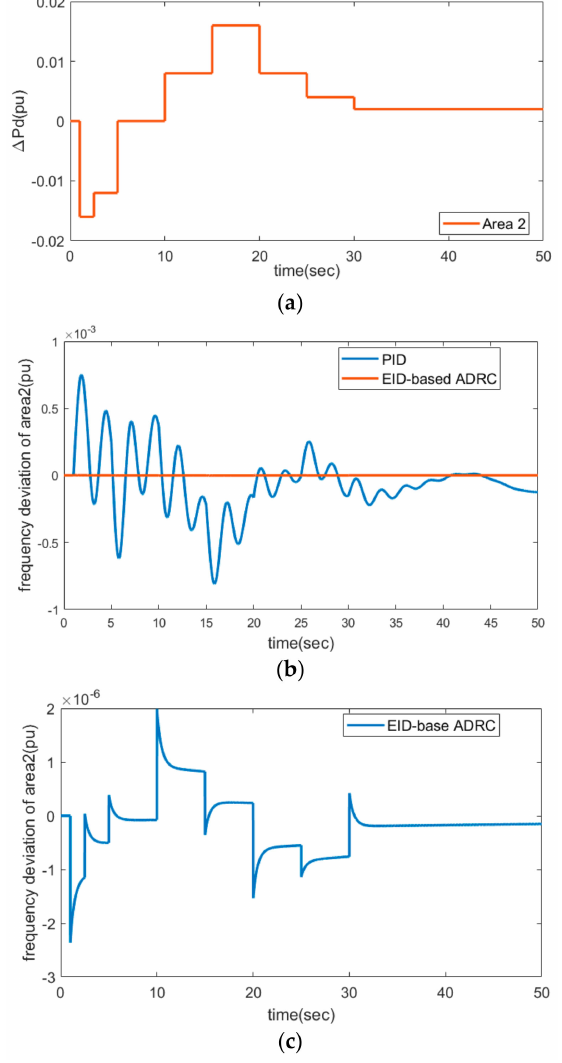
Figure 8. Dynamic response of Area 2, ( a ) load variation of Area 2; ( b ) frequency deviations of Area 2 with di ff erent controller; ( c ) enlarged view under